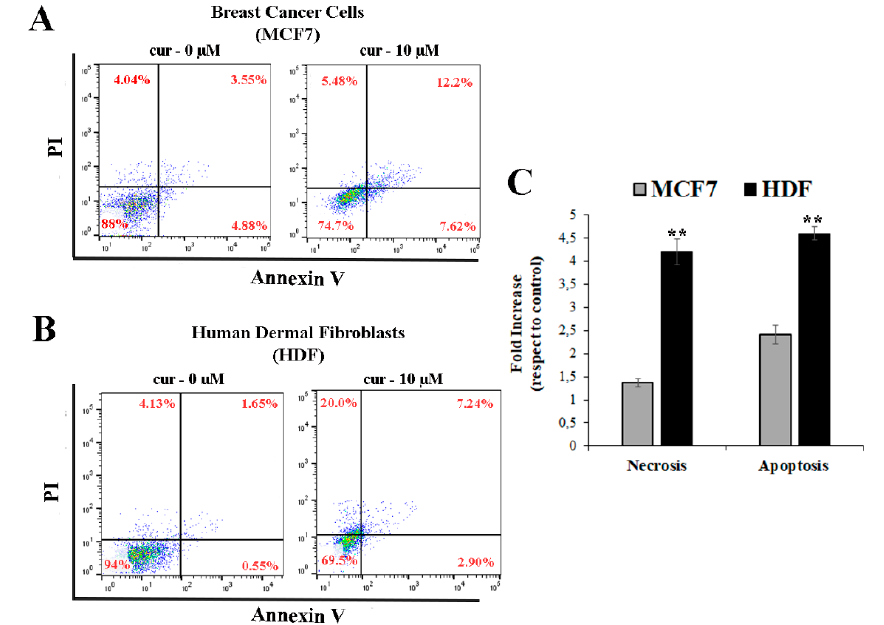
Figure 5. Curcumin-induced apoptosis. HDF and MCF7 cells were treated with 10 µM of curcumin for 24 h followed by washing, trypsinization, and incubation with Annexin V-FITC and propidium iodide (PI). Representative cytograms from three independent experiments are shown for ( A ) MCF7 and ( B ) HDF cells. ( C ) Apoptosis and necrosis quantified as a fold increase with respect to the control (untreated cells). Total apoptosis was calculated by considering early apoptosis (lower right) and late apoptosis (upper right). Data are the mean of at least three experiments, and error bars represent ± SD ** p ≤ 0.001 versus control.